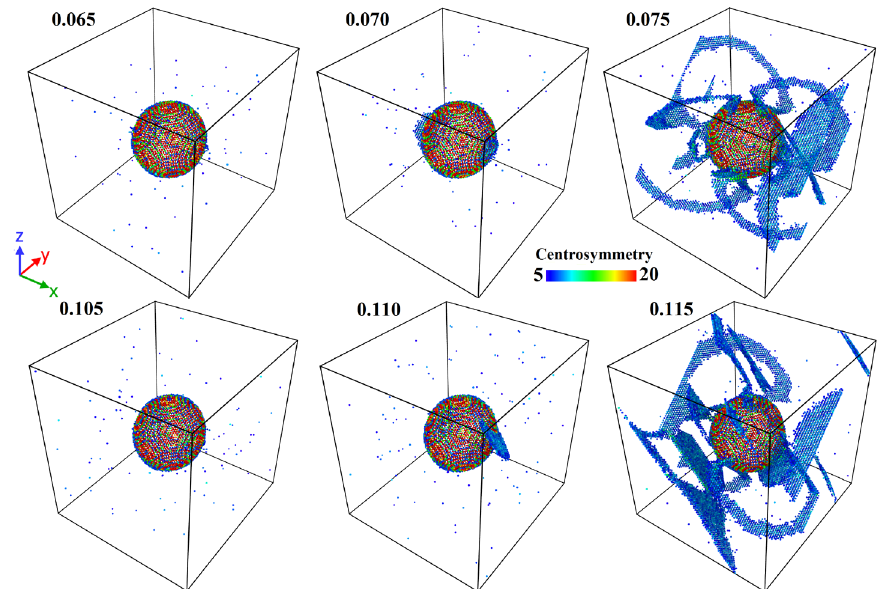
Figure 2. Plasticity incipience (nucleation of dislocations) in aluminum single crystals with spherical nanopores 8 nm in diameter. Top and bottom panels represent two different deformation paths; the current values of the engineering strain are shown near the atomic configurations. Atom colors represent the values of the centrosymmetry parameter (in square angstroms), where the values ≈ 5 (blue) correspond to stacking faults and the values ≥ 20 (red) correspond to free surfaces. Only the atoms belonging to defect areas (the centrosymmetry parameter is greater than 5 square angstroms) are shown.